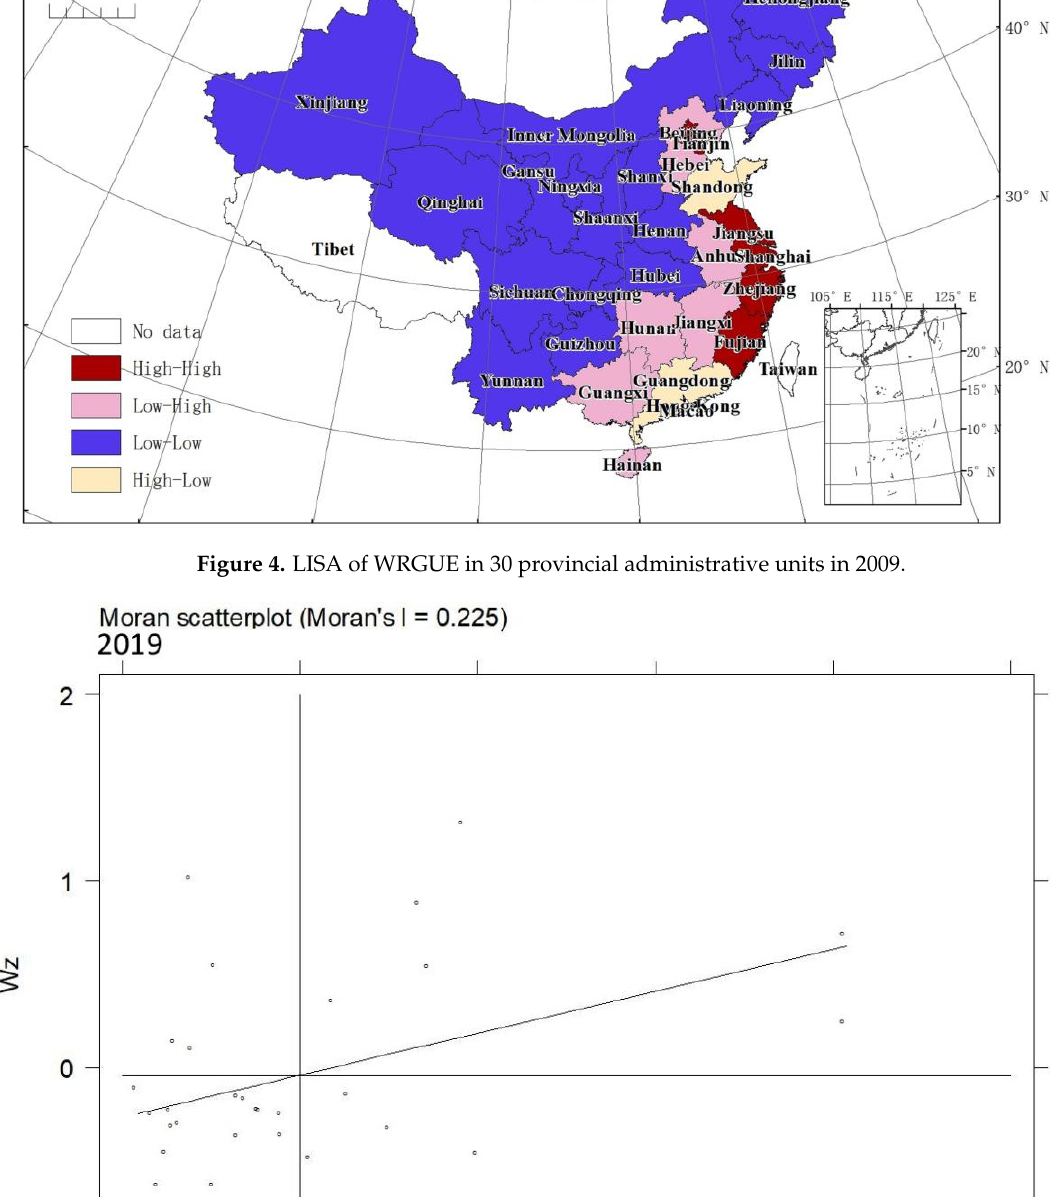
Figure 5. The Moran scatterplot maps of WRGUE in 30 provincial administrative units during in 2019.